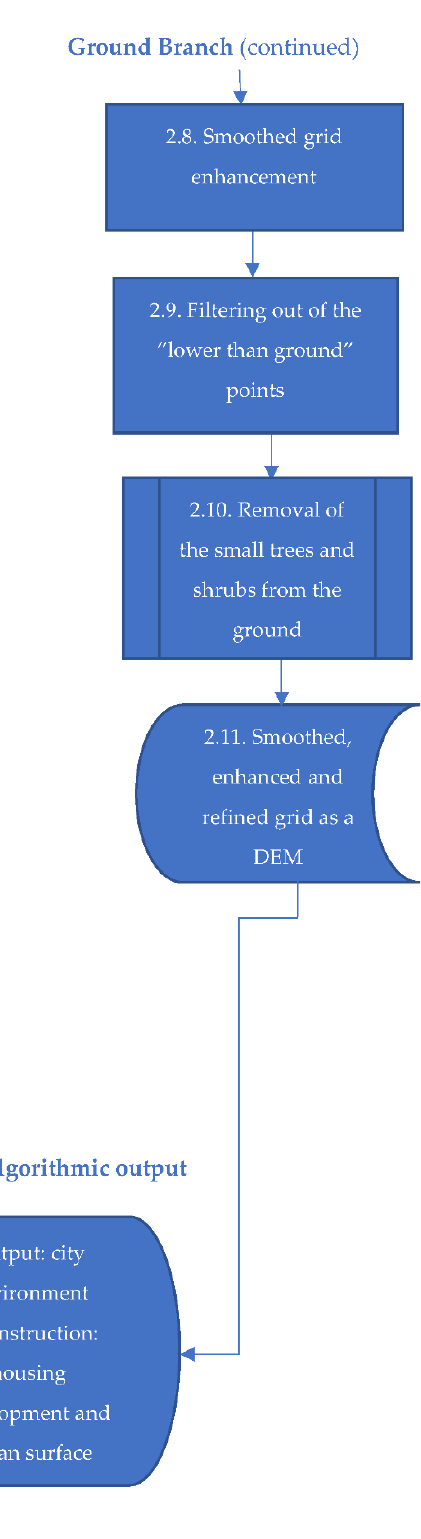
Figure 1. ( a ) The upper part of the flowchart due to the two-branched digital elevation models Figure1. ( a )Theupperpartoftheflowchartduetothetwo-brancheddigitalelevationmodelsgeneration generation (DEM-G)/automated feature extraction (AFE) algorithmic solution within the high (DEM-G) / automated feature extraction (AFE) algorithmic solution within the high polyhedral modeling polyhedral modeling (HPM) frameworks. Only airborne lidar (ALS) data are processed according to (HPM) frameworks. Only airborne lidar (ALS) data are processed according to this flowchart. ( b ) The this flowchart. ( b ) The lower part of the flowchart due to the two-branched DEM-G/AFE algorithmic lower part of the flowchart due to the two-branched DEM-G / AFE algorithmic solution within the HPM solution within the HPM frameworks. Only ALS data are processed according to this flowchart. frameworks. Only ALS data are processed according to this